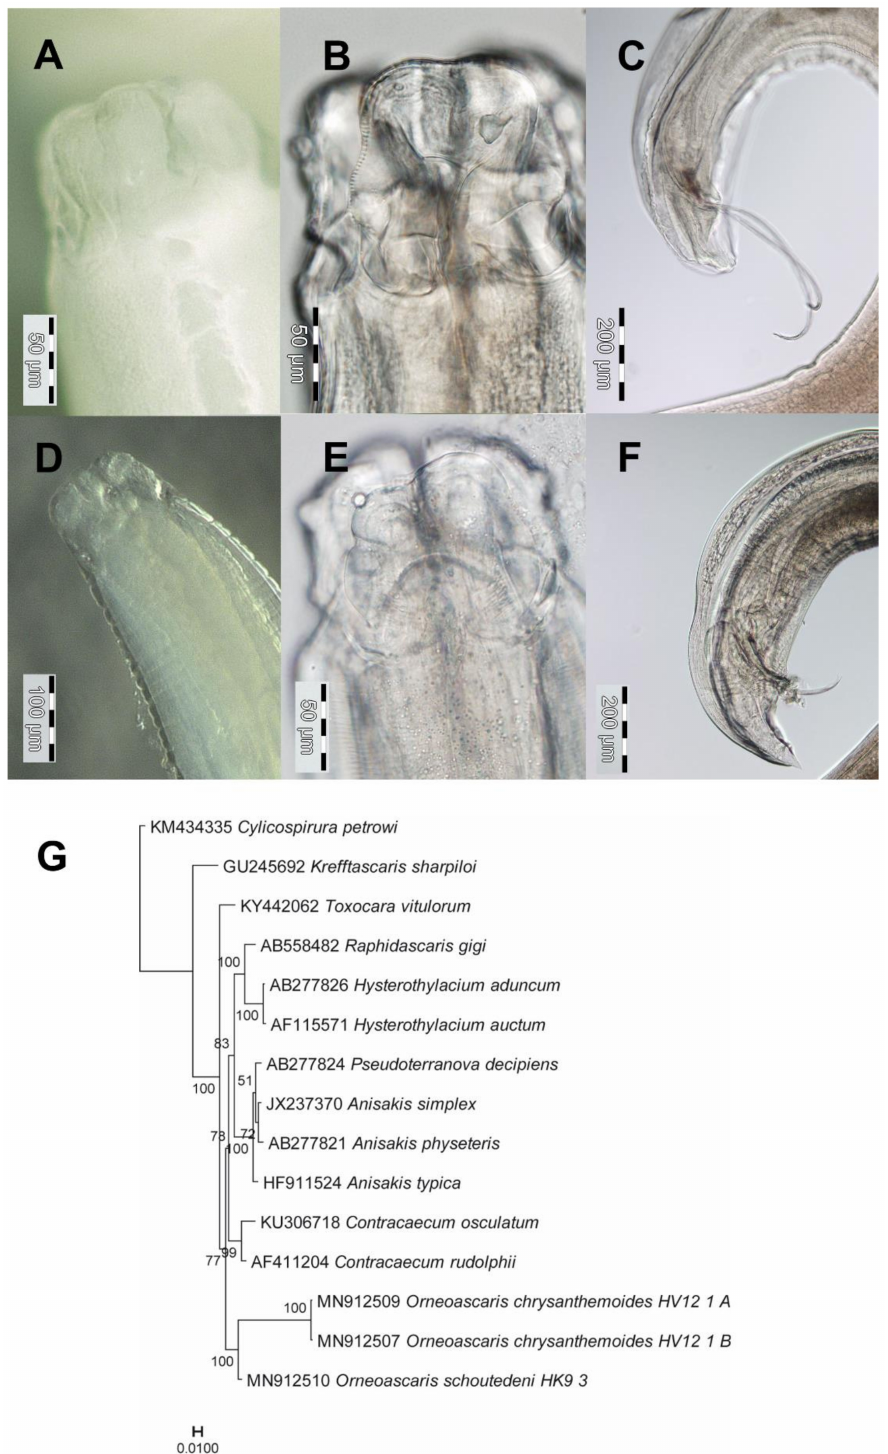
Figure 1. Orneoascaris chrysanthemoides ( A – C ) and O. schoutedeni ( D – F ) and their phylogenetic relationships ( G ). Anterior end with lateral view on the lips of live specimens ( A , D ). Dorsal lip with dentigerous ridges ( B , E ). Tail region of a male with spicules ( C , F ). Scales are given in each photograph. ( G ) Bayesian tree of partial 18S rDNA and partial ITS1 sequences of Orneoascaris spp. and other Ascaridoidea species, rooted by the spirurid Cylicospirura petrowi . Posterior probability values are indicated. Scale bar indicates substitutions per